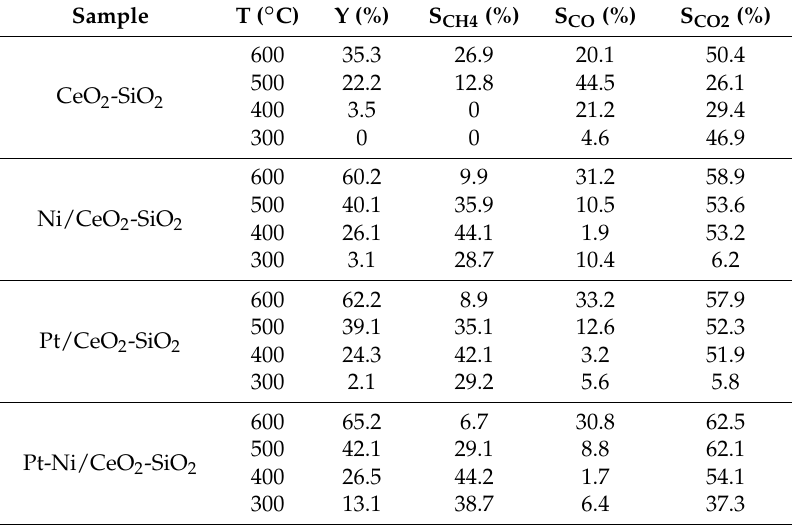
Table 3. Hydrogen yield and main carbon-containing products selectivity during reforming tests